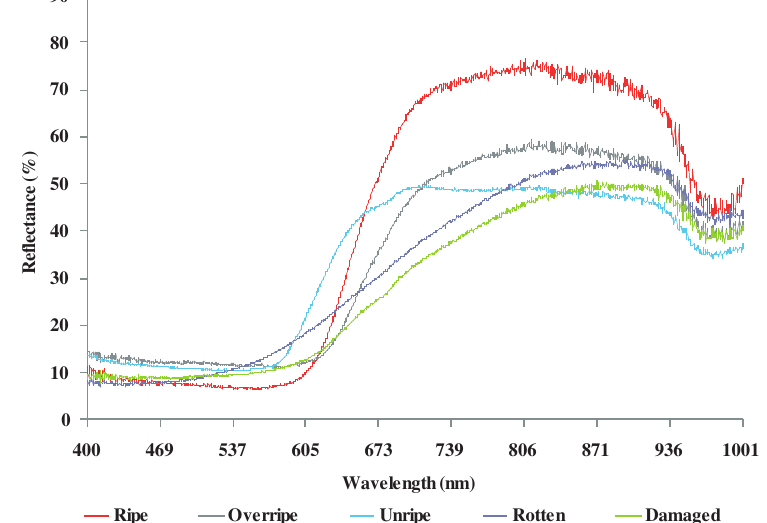
01020304050607080904004695376056737398068719361001Wavelength(nm) R e f l ec t a n ce ( % ) Figure 3. Spectral properties of cherry fruits regarding the ripe and health status